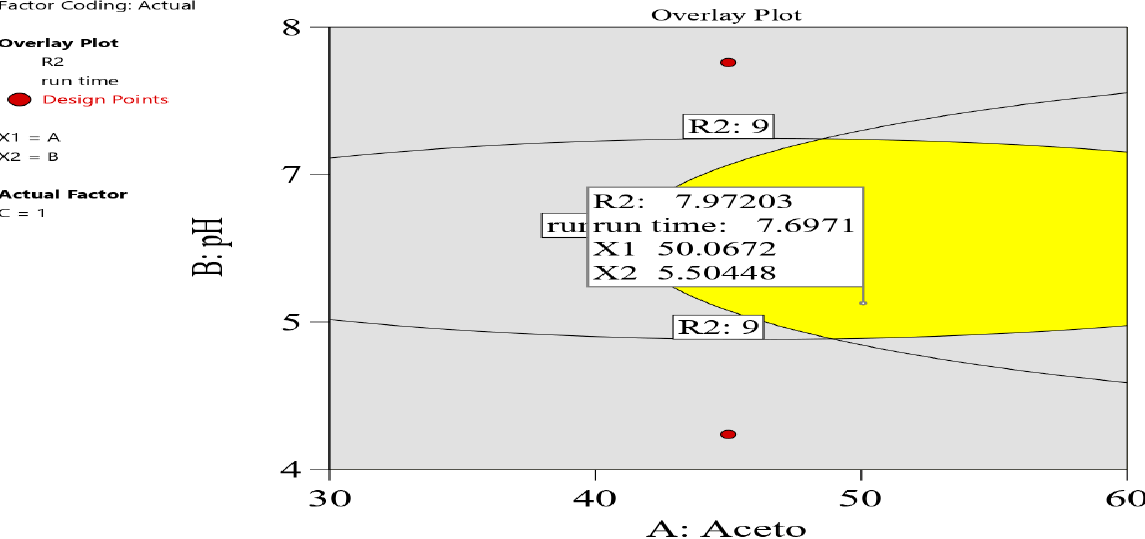
Figure 3. Overlay plot of the responses for the interaction of two factors, showing the sweet spot colored in yellow.